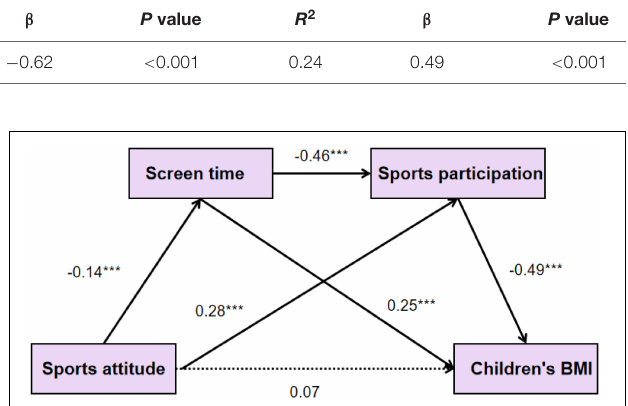
FIGURE 1 | Path relationship between family sports attitude, sports participation, screen static time, and children’s